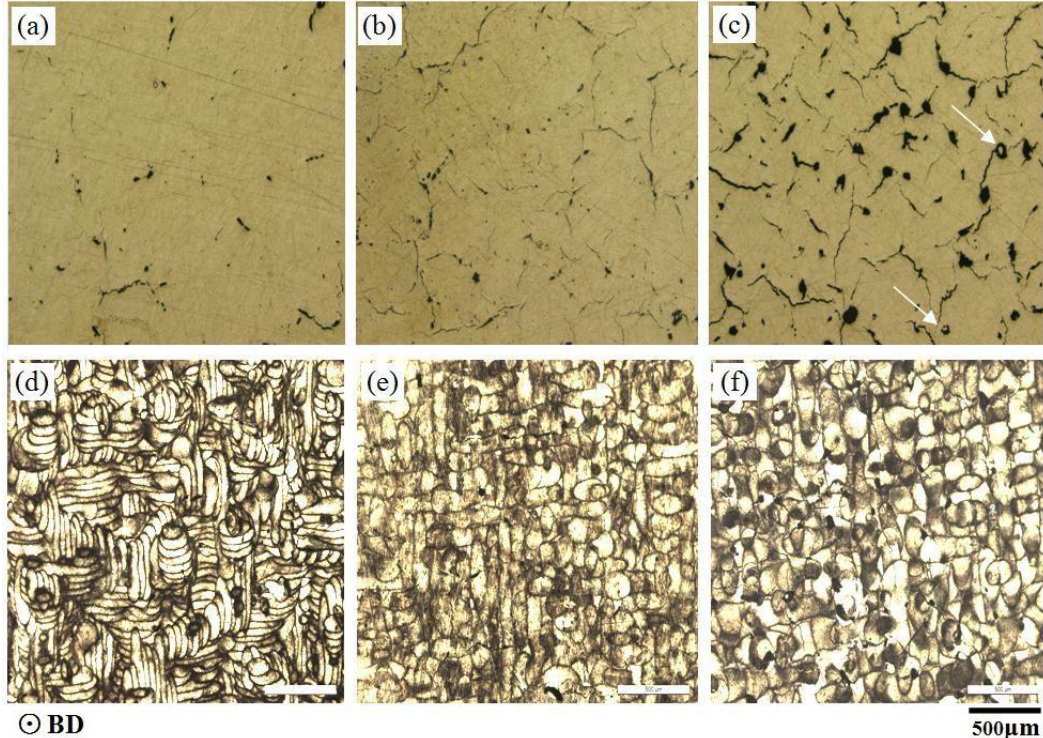
Figure 9. LM images show the etched morphologies of the SLM 2124 transversal surface at hatch spacings of ( a , d ) 0.04, ( b , e ) 0.1 and ( c , f ) 0.17 mm.